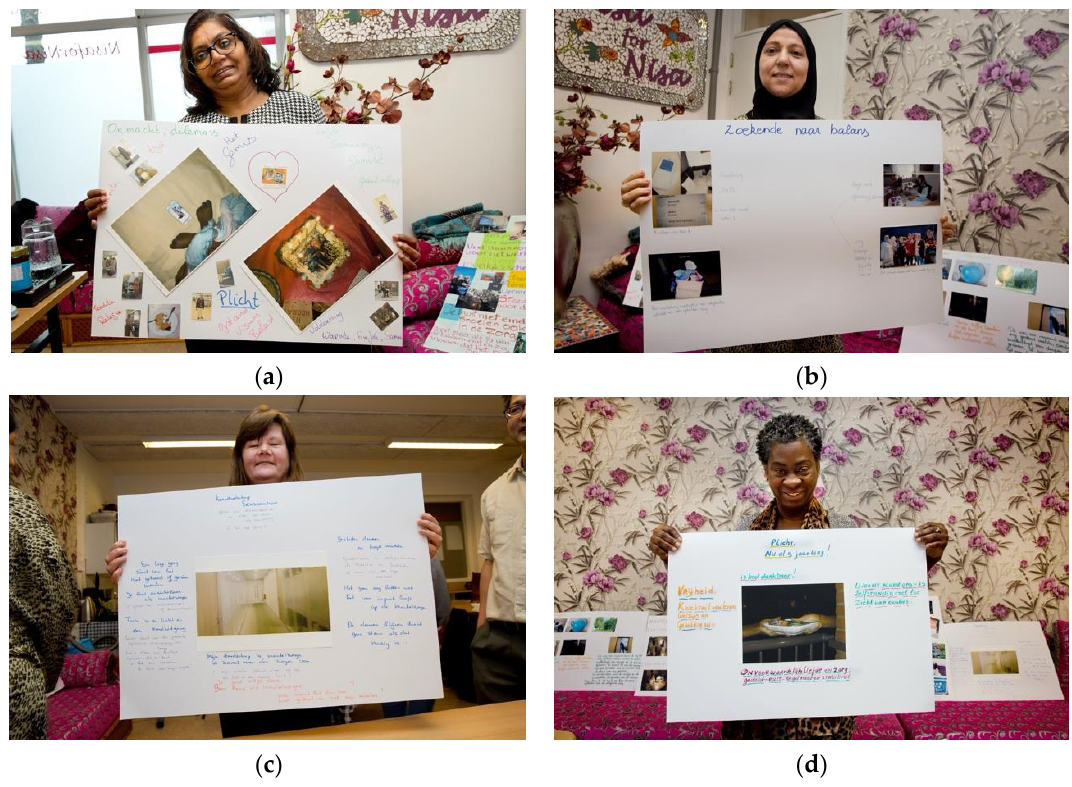
Figure 1. ( a – d ) Portrait of community researchers with chosen photographs.